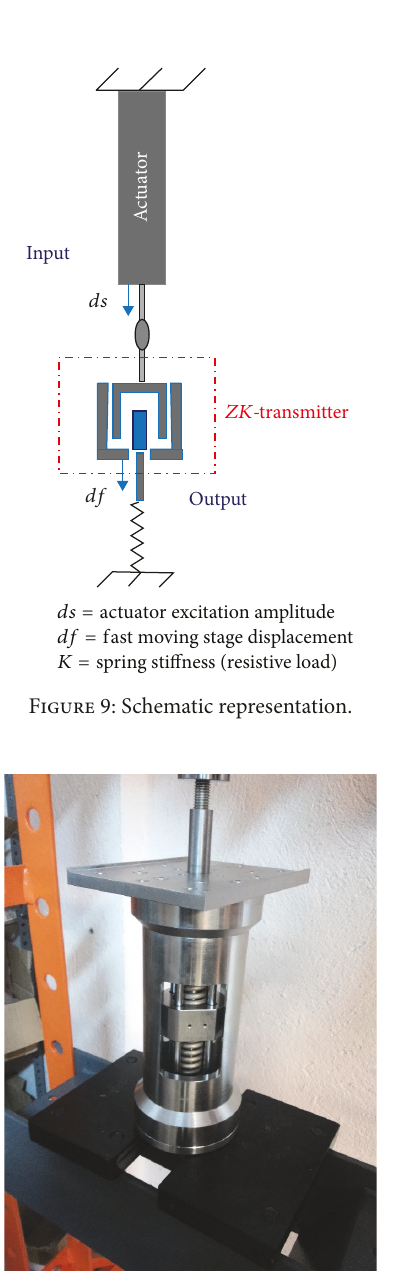
Figure 10: Spring used for the setup.